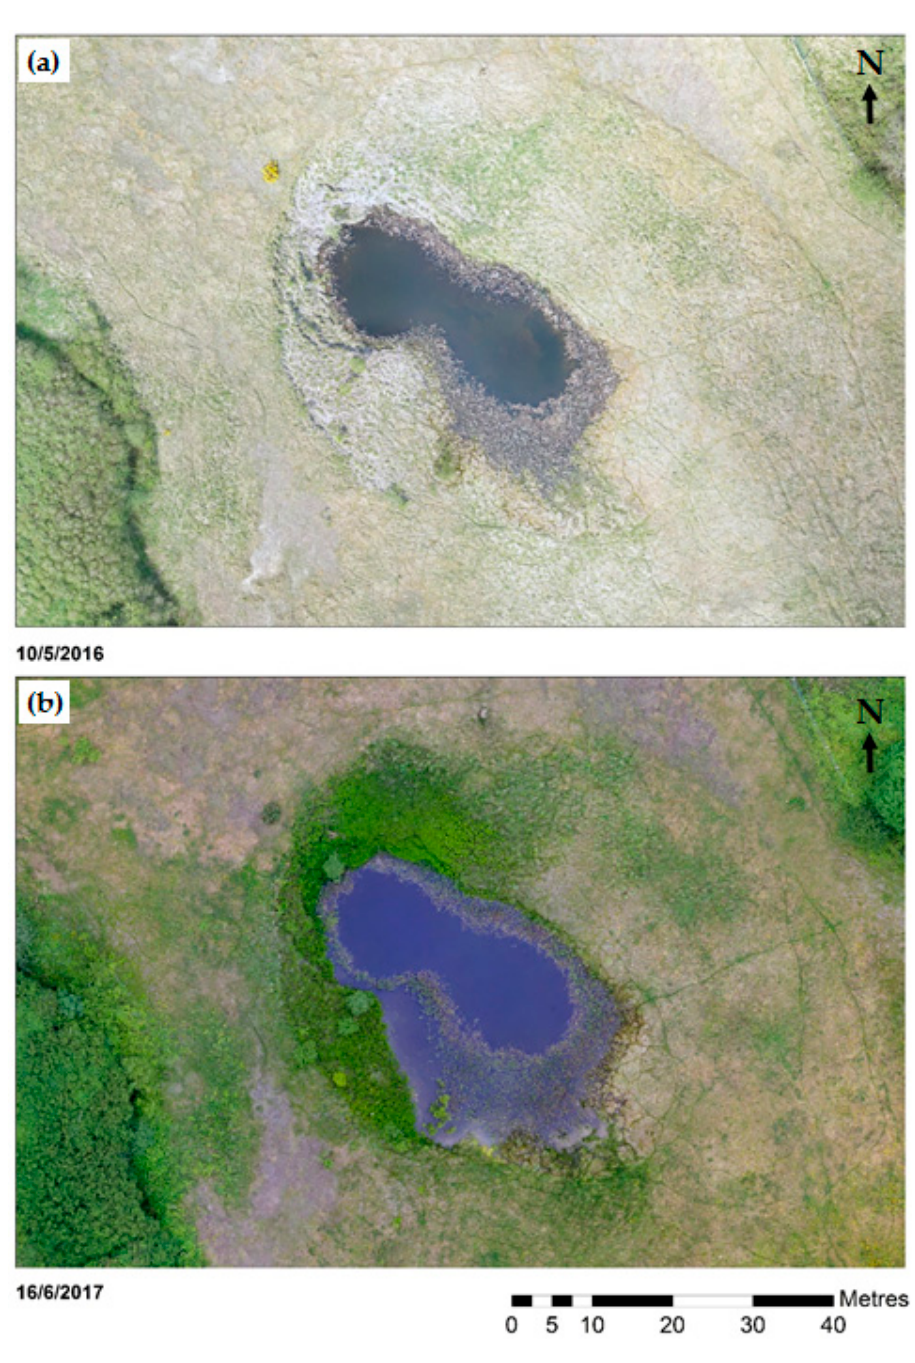
Figure 11. Comparison between VHR ortho-photographs from the ( a ) 10 May 2016 and ( b ) 16 June 2017 SUAV campaigns carried out at the Maiden Mount salt mine collapse at Carrickfergus.